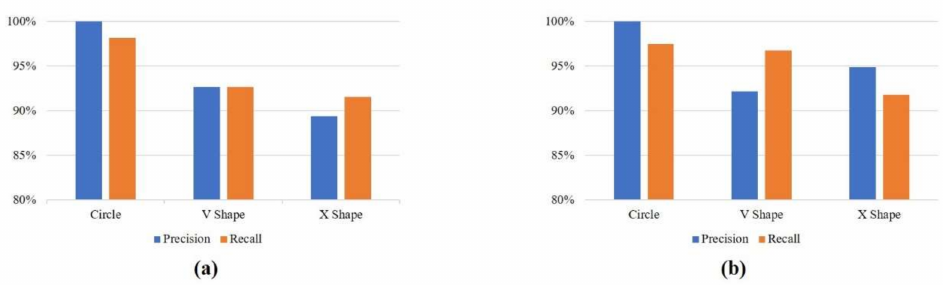
Figure 8. Precision and recall with the collected data. ( a ) RNN-BiLSTM; ( b )